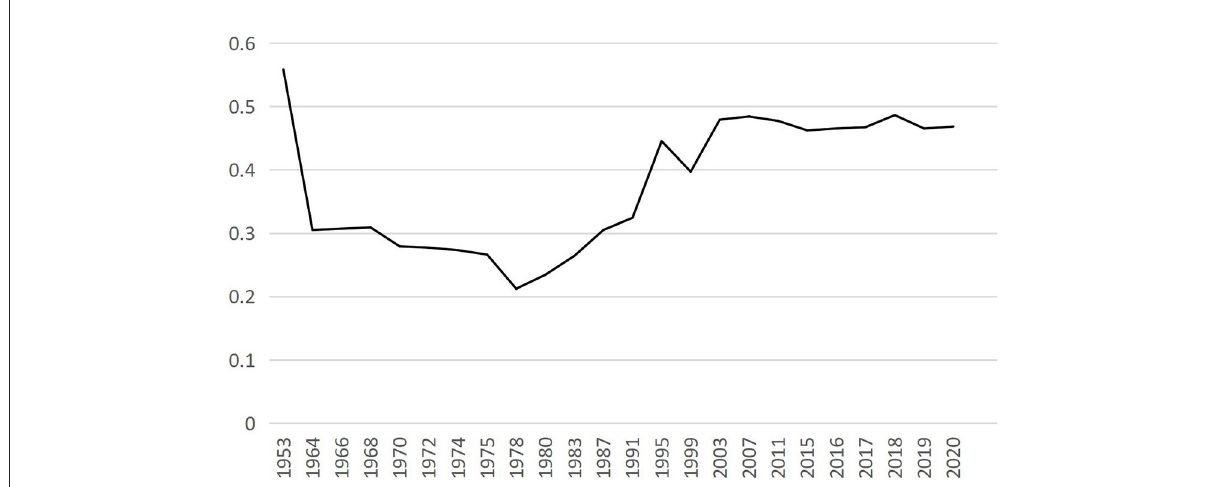
FIGURE1 Gini coefficient of Chinese resident income from 1953 to 2020. The Gini coefficient of 2003–2020 is from the China yearbook of household survey (calendar years), the Gini coefficient of 1953–1978 is from the World Income Inequality Database (WIID), and the author estimates other